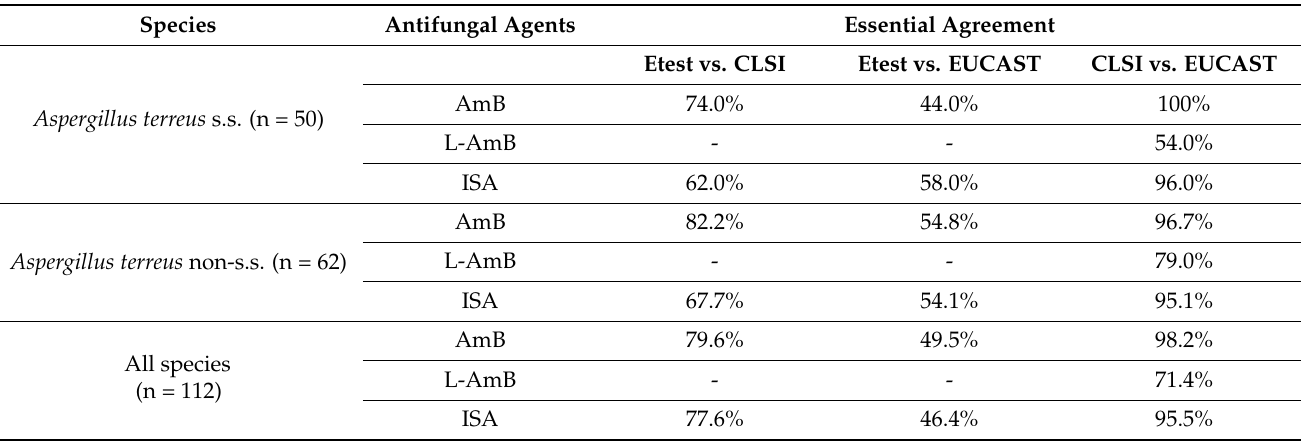
Table 2. Essential agreement between broth microdilution and Etest results of Aspergillus section Terrei isolates (n =